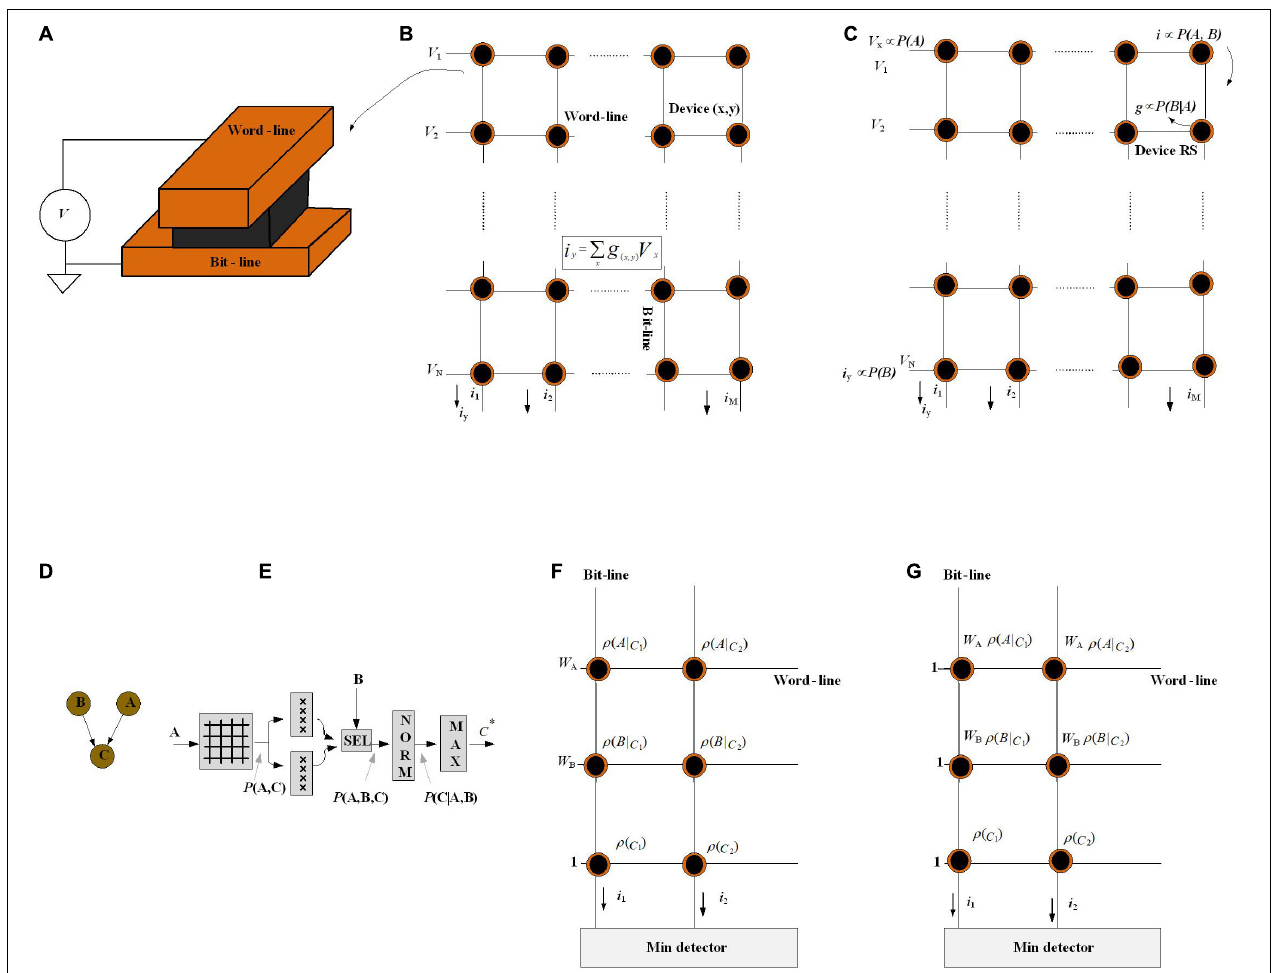
FIGURE 10 | (A) Schematic of the memristor device in which the device’s active material is surrounded by two electrodes [top (wordline) and bottom (bitline)]. (B) Ohm’s law: i = g . V is utilized to perform multiplier operation. (C) The crossbar array is used as a Bayesian inference system. (D) Graphical model for Bayesian network. (E) Implementation of the Bayesian classifier. (F) Implementation of the naïve Bayesian classifier for a network of two attributes. (G) Implementation of a different way to calculate I c . In this method, the weight of the i th attribute ( w i ) is stored in the cell